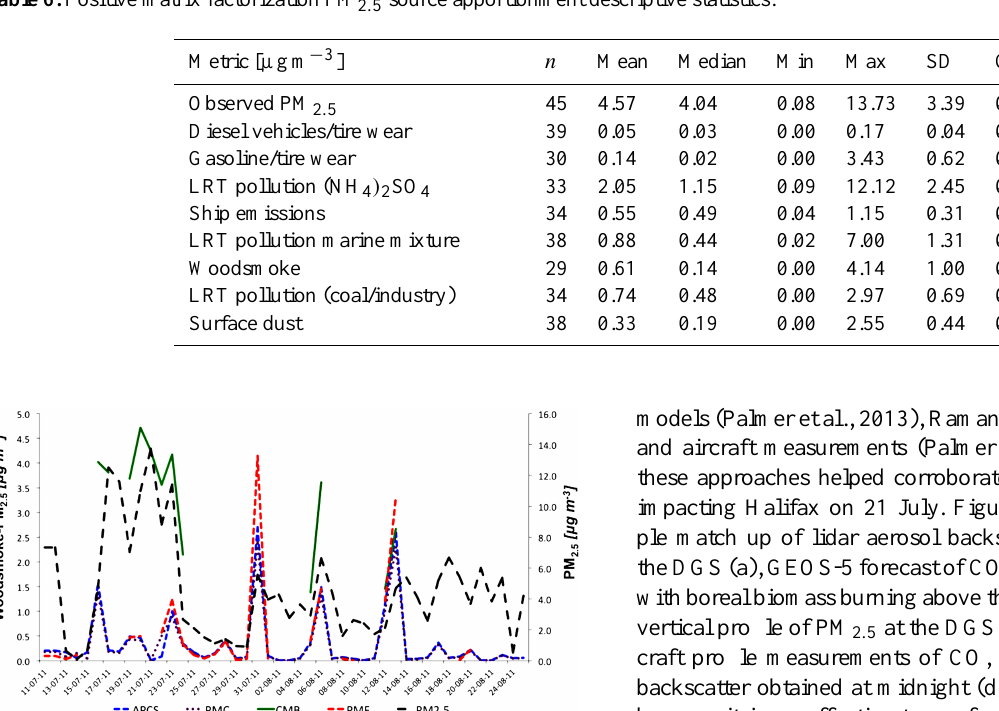
Table 6. Positive matrix factorization PM 2 . 5 source apportionment descriptive statistics.